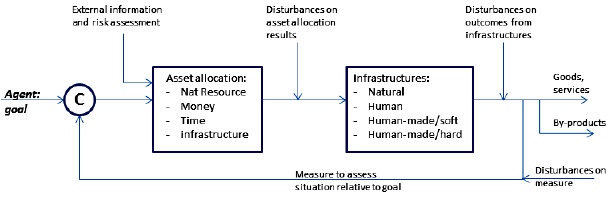
Fig. 1 . Representation of a component of a social-ecological system (SES) as an elementary feedback control loop (FBCL), adapted from Anderies 2015. Note “C” in the circle to the left represents “comparison” of the goal to the actual measured outcome. In feedback control, “C” is often simply the difference between the goal measure and output